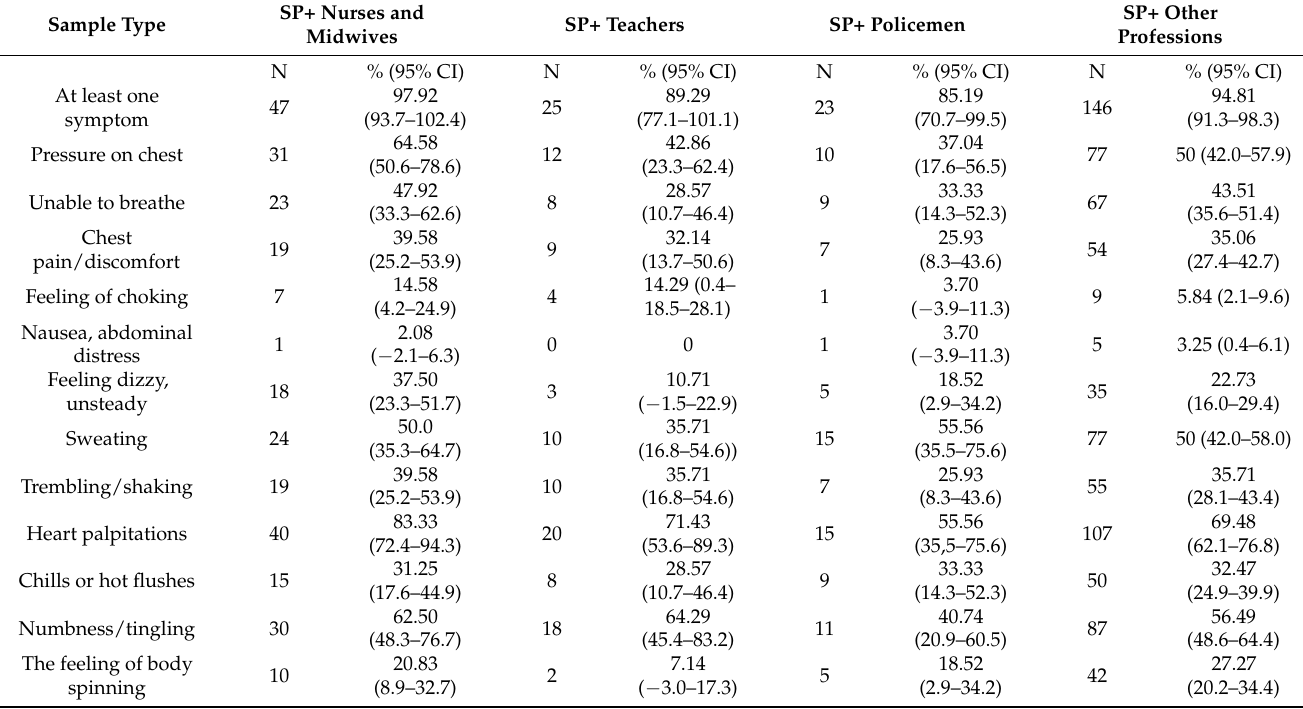
Table 6. Prevalence of psychosomatic attributes in ISP experiences in the studied SP+ professions groups.